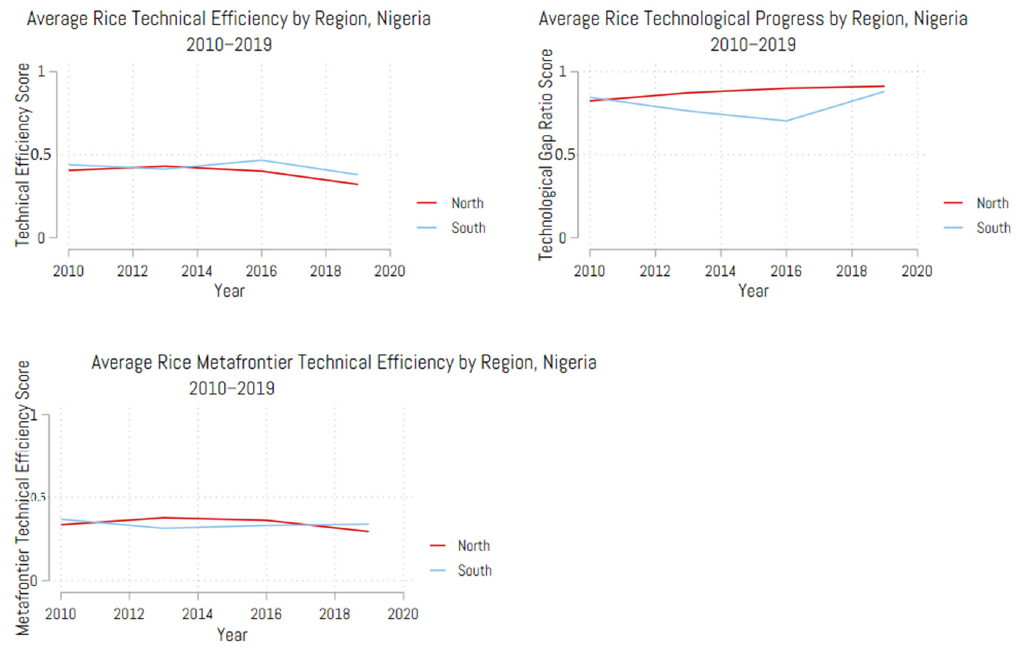
Figure 1. Average various rice efficiency scores by region, 2010–2019.